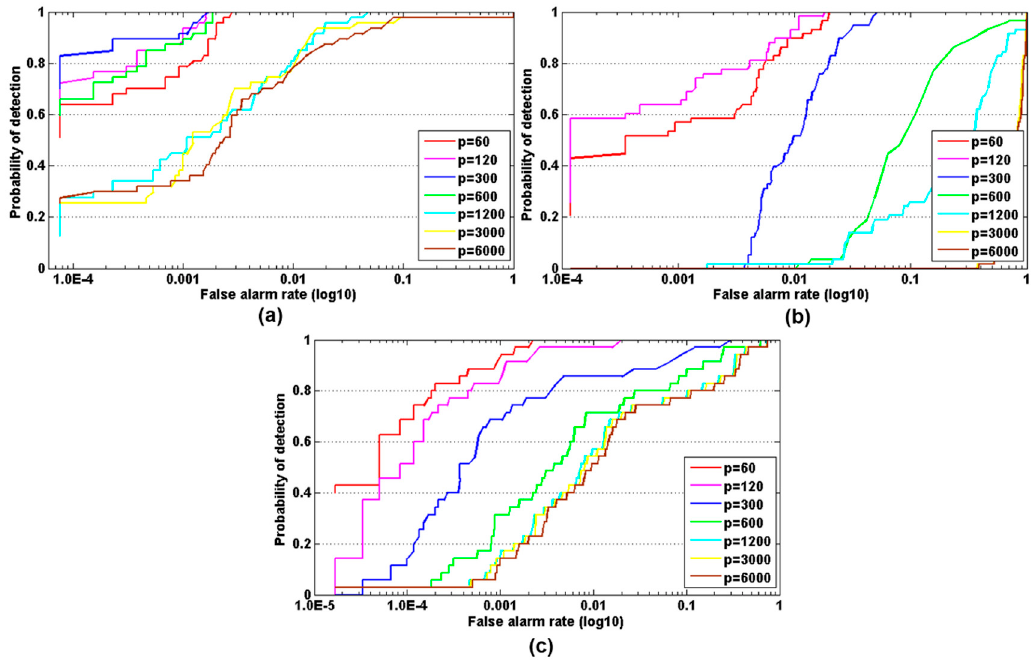
Figure 12. The logarithmic receiver operating characteristic (ROC) curves of RSLAD with different choices of sampled pixels p on the three datasets: ( a ) PaviaC; ( b ) San Diego; and ( c ) Botswana.